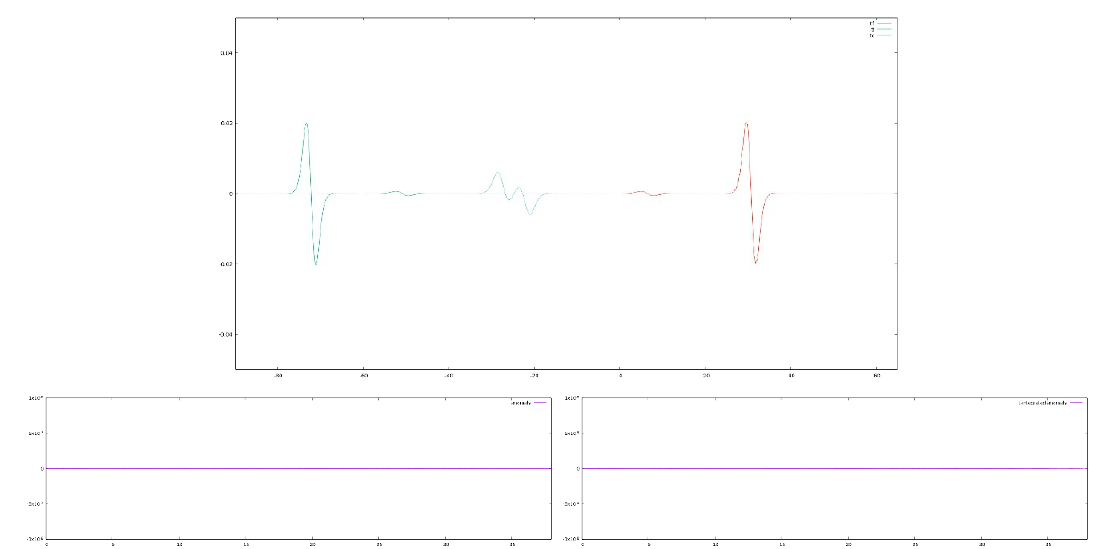
Figure 5 . Top (cid:12)gure shows the anomaly density of (cid:11) 2 in (4.11); i.e. the function ( w x v t u x ) plotted e in x -coordinate for three successive times, t i = before collision (green), t c = collision (blue) and t f = after collision (red), for the 2-soliton of (cid:12)gure 2. Bottom (cid:12)gures show the plots of the anomaly (cid:11) 2 vs. t and the t -integrated anomaly R t (cid:11) 2 vs. t , respectively. e t i e